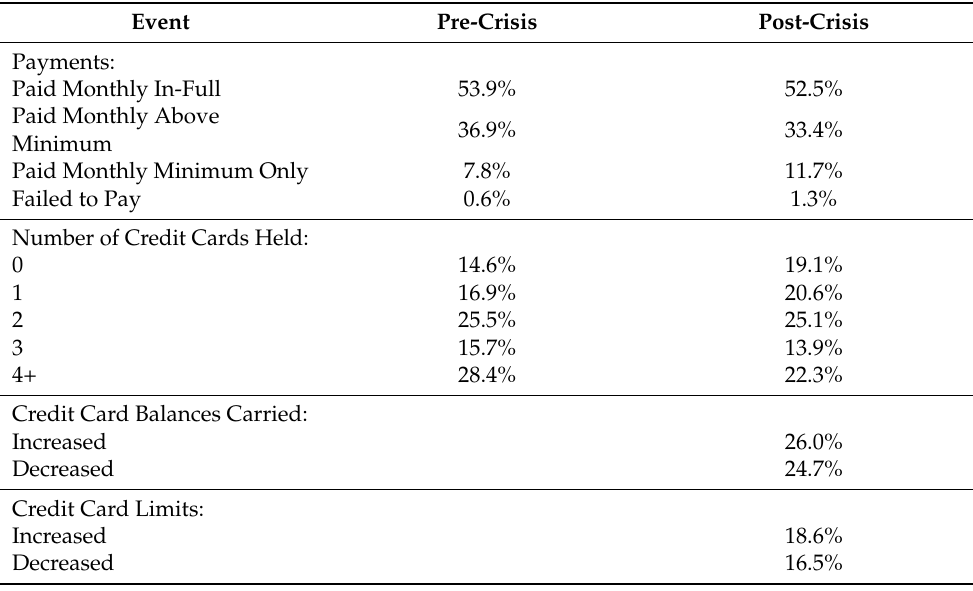
Table 3. The Financial Crisis: Credit Card Behavior of Surveyed